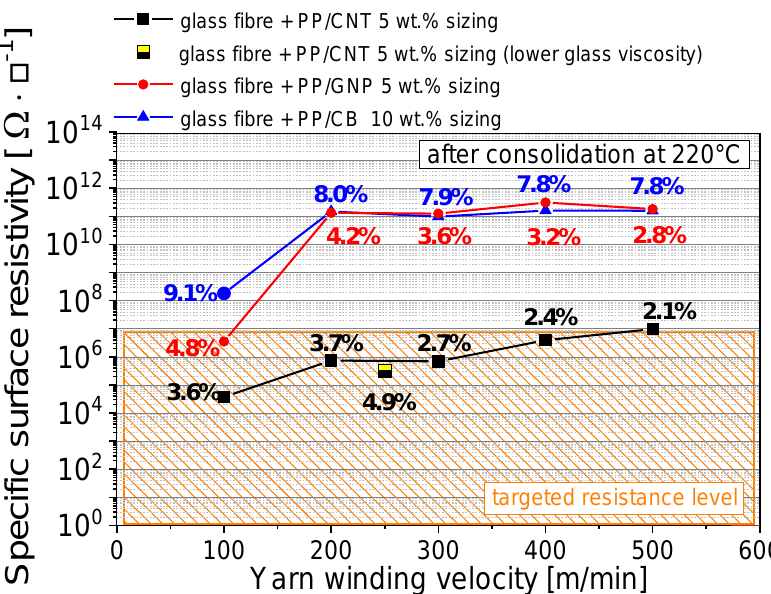
Figure 6. Influence of the winding velocity during the fibre spinning process on electrical resistivity, measured on in-line nanostructured glass fibres which are embedded into continuous polypropylene/glass fibre composites via compression molding (small percentage numbers specify the organic content on the fibre surface).